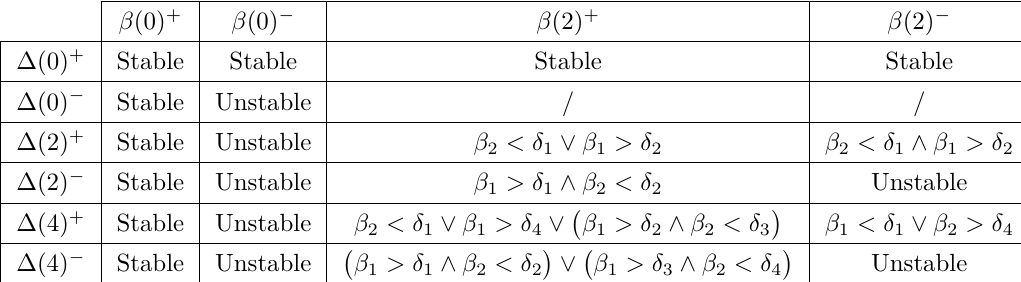
Table 2 . Realisation of the stability constraint in eq. (B.21), depending on the number of roots of the polynomials e ∆ and e β and the sign of their leading coefficient. We write ∆( n ) s and β ( n ) s to respectively denote the number n of roots and the sign s of the leading coefficient of the polynomials e ∆ and e β . The roots of e ∆ are noted δ i with δ 1 < · · · < δ n , those of e β are noted β i with β 1 < β 2 . Cases where the stability condition in eq. (B.21) is satisfied for any values of the roots are referred to as Stable, and cases where the condition cannot be satisfied are referred to as Unstable. For cases where the realisation of eq. (B.21) depends on the value of the roots, the additional constraints to be satisfied by them are reported. Finally, two cases never occur because of the constraint of a positive e ∆ at the location of the roots of e β